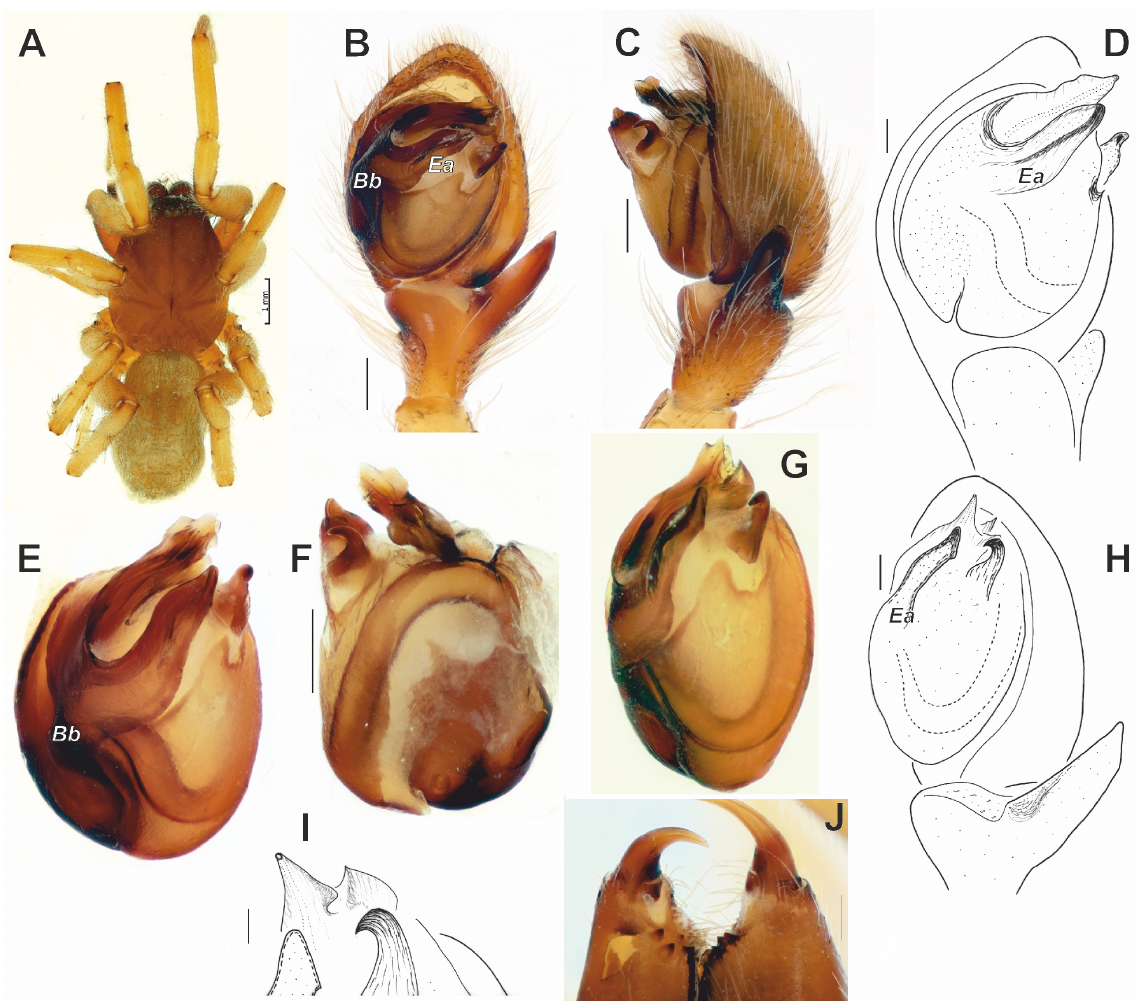
Fig. 11. Haplodrassus medes sp. nov., holotype, ♂ (MHNG). A . Habitus, dorsal view. B–D, H . Palp, ventral, retrolateral, proventral and retroventral views. E–G . Bulb, proventral, dorsal and retroventral views. I . Apical portion of bulb, retroventral view. J . Chelicerae, posterior view. Abbreviations: Bb = bulge of bulb; Ea = embolic apophysis. Scale bars: A = 1 mm; B–C, F, J = 0.2 mm; D, H–I = 0.1